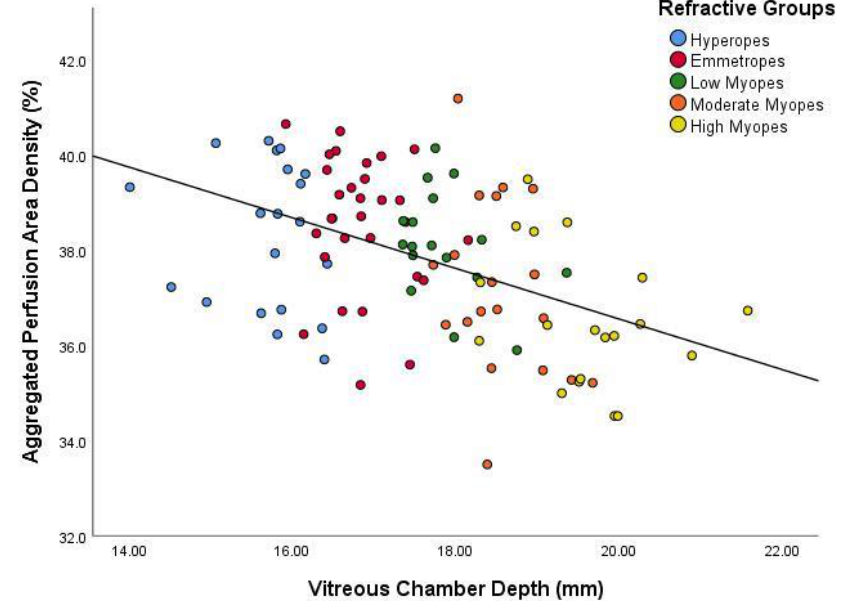
Figure 4. Scatter plot demonstrating the relationship between aggregated perfusion area density and vitreous chamber depth. The colours distinguish the subjects for their particular eye size bin. The regression line indicates a significant inverse relationship (r 2 = 0.225, p < 0.001).